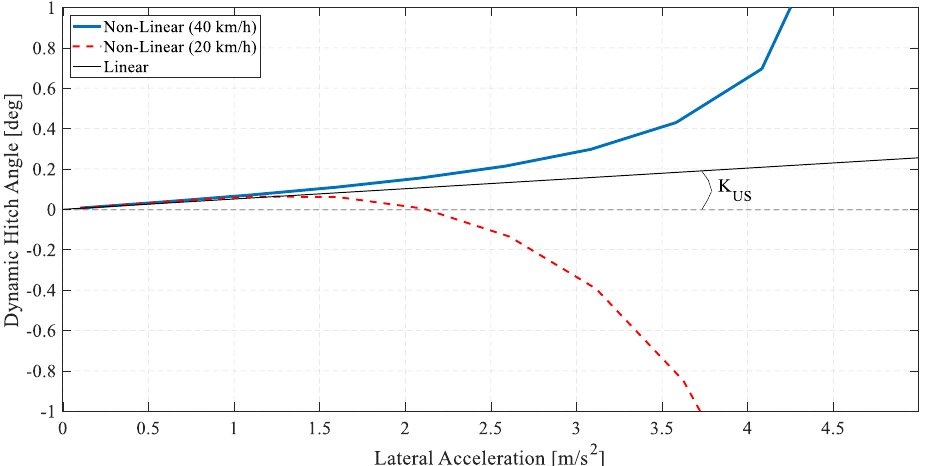
Figure 13. Understeer characteristics for the non-linear model at 40 km/h (blue solid line) and at 20 km/h (red dashed line) and for the linear model (black solid line).